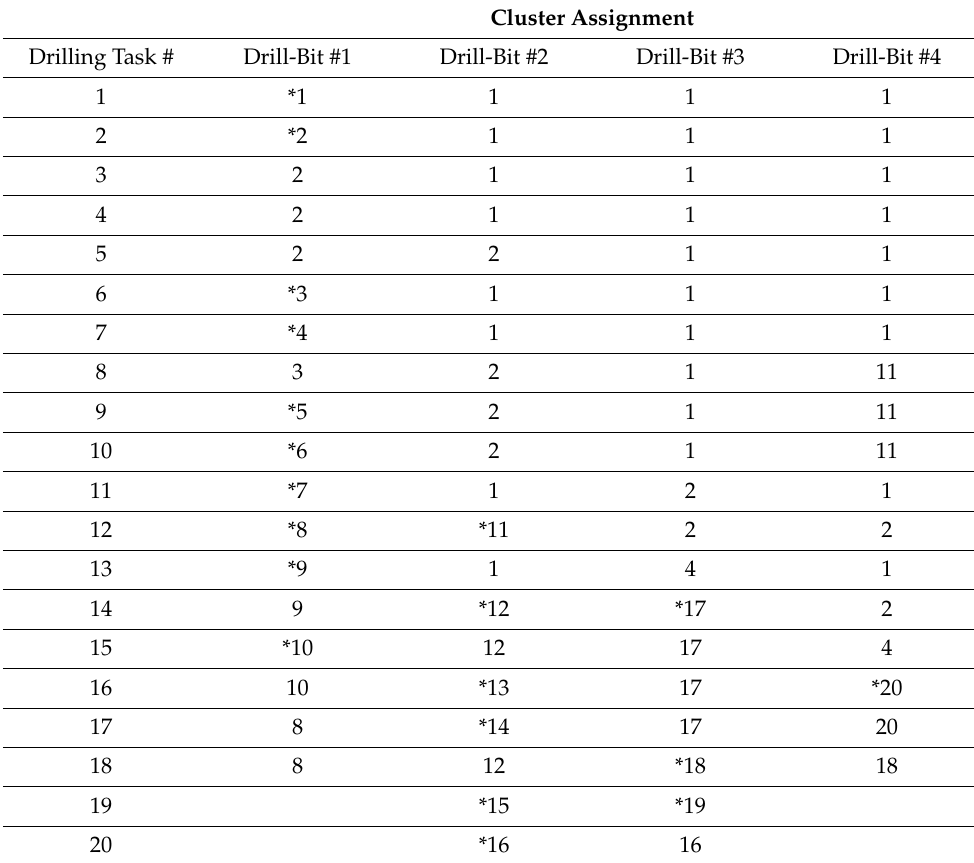
Table 1. Cluster assignment history of drill-bits #1 ~